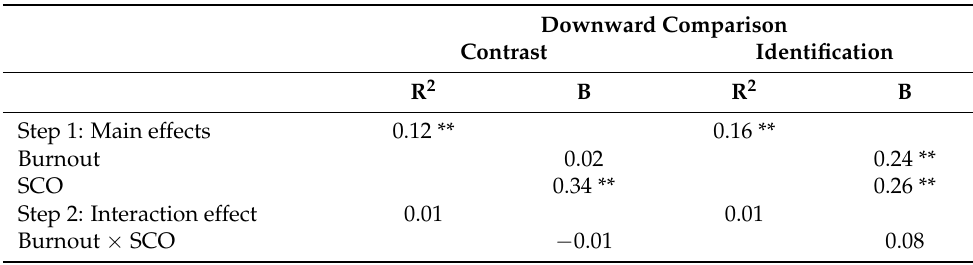
Table 2. Results of hierarchical regression of positive and negative affect as a response to downward comparison in Study 1 [13].